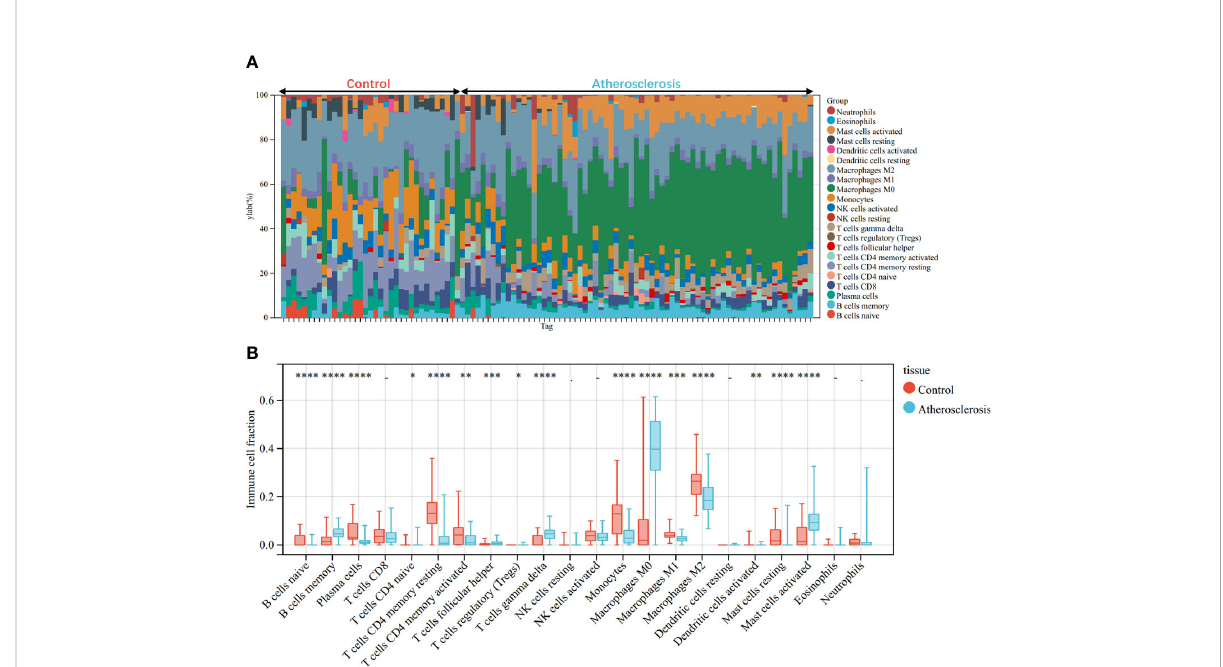
FIGURE 10 Immune cell in fi ltration mode in AS. (A) The relative percentage of 22 immune cell subpopulations out of 104 samples from the GSE100927. (B) The ratio of 22 immune cells between AS and control in GSE100927. *p < 0.05; **p < 0.01; ***p < 0.001; ****p < 0.0001.